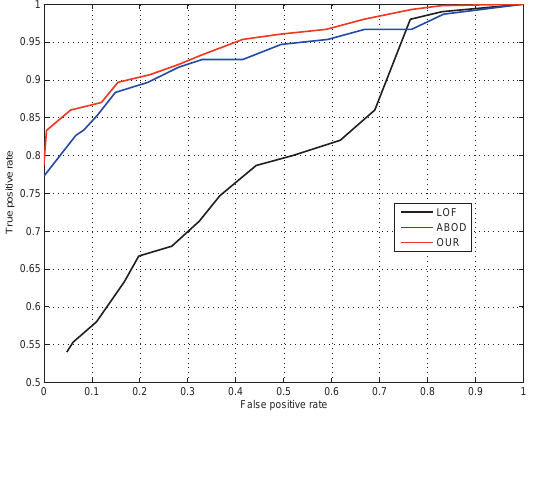
Fig. 2. ROC curves on the synthetic